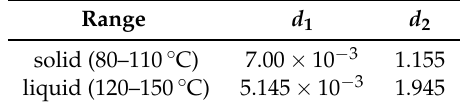
Table 2. Factors for the linear equation c p ( ϑ ) = d 1 the heat capacity of MCHH.